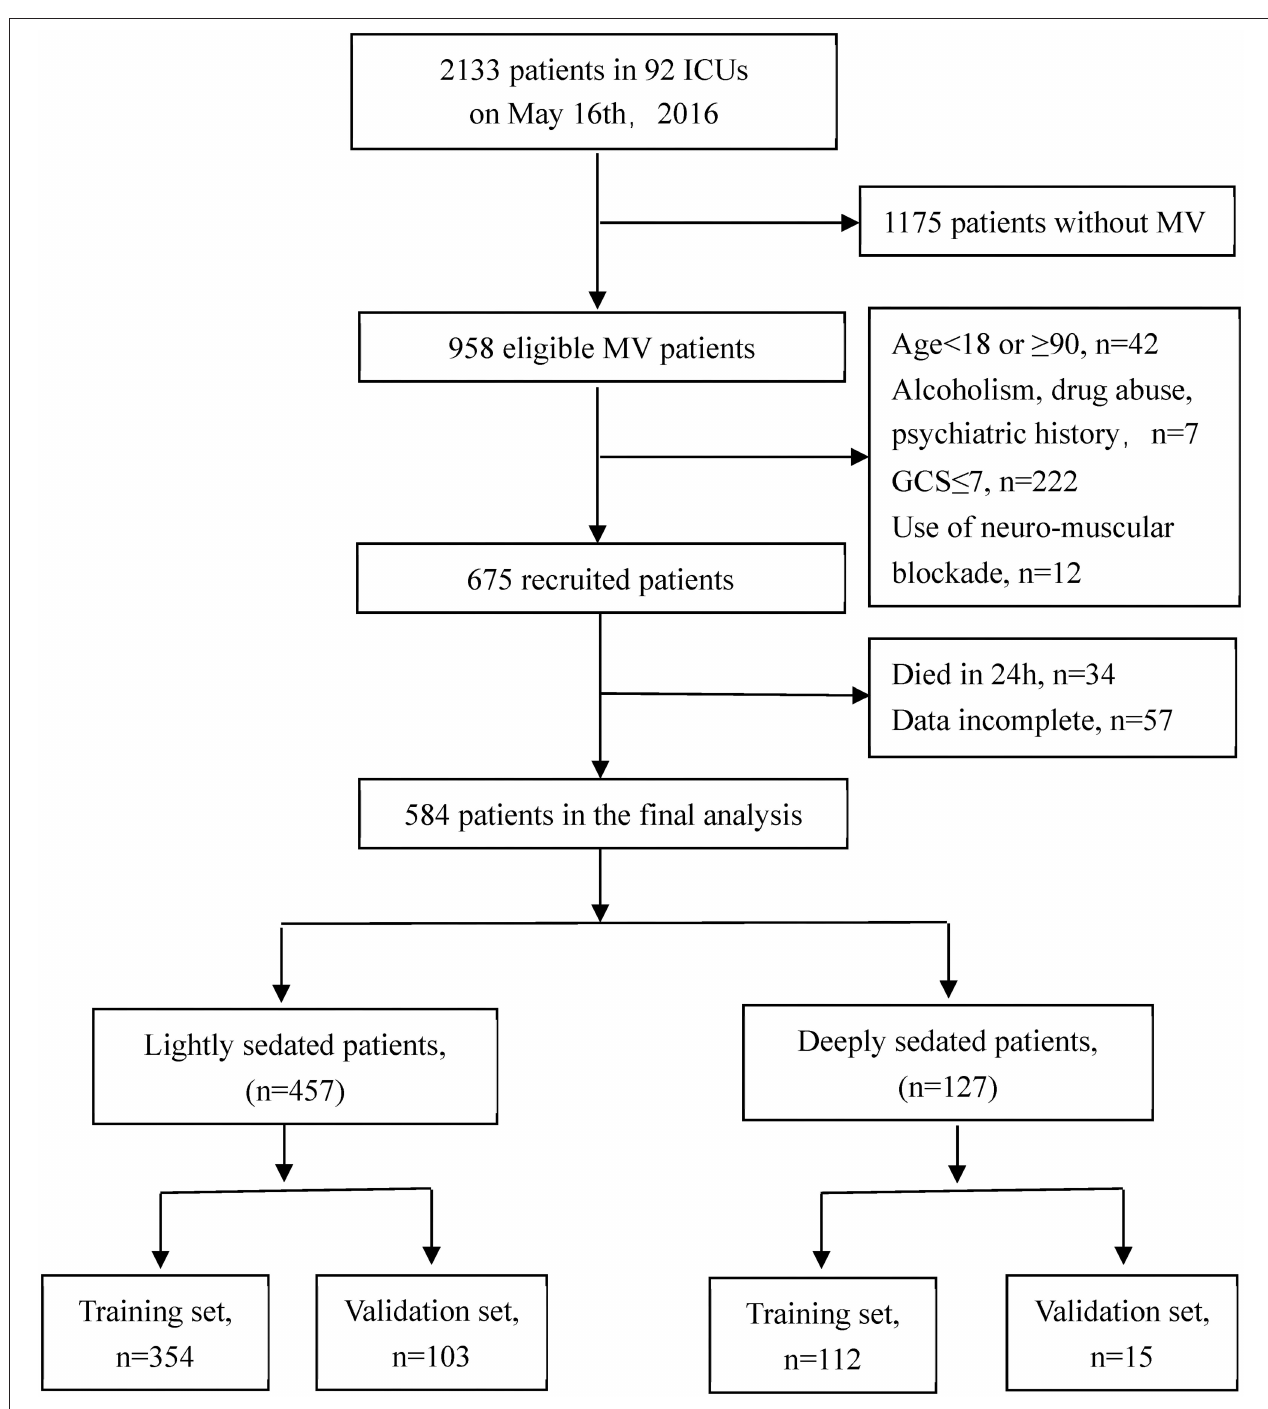
FIGURE 1 | Flow diagram of the study.